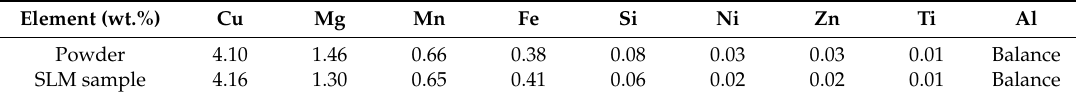
Table 1. The main chemical compositions of the powder used in selective laser melting (SLM) determined by inductively coupled plasma-atomic emission spectrometry. Element (wt.%)